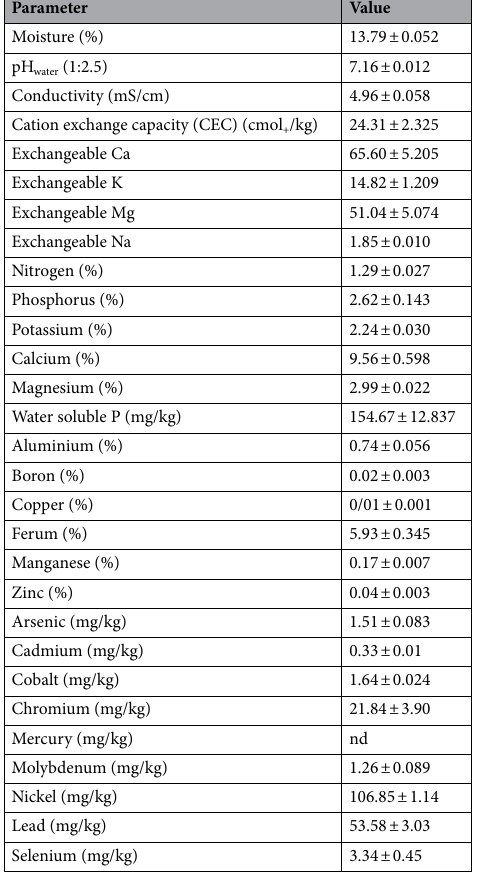
Table 2. Chemical characteristics of PG organic. MS ISO/IEC 1702; nd = not